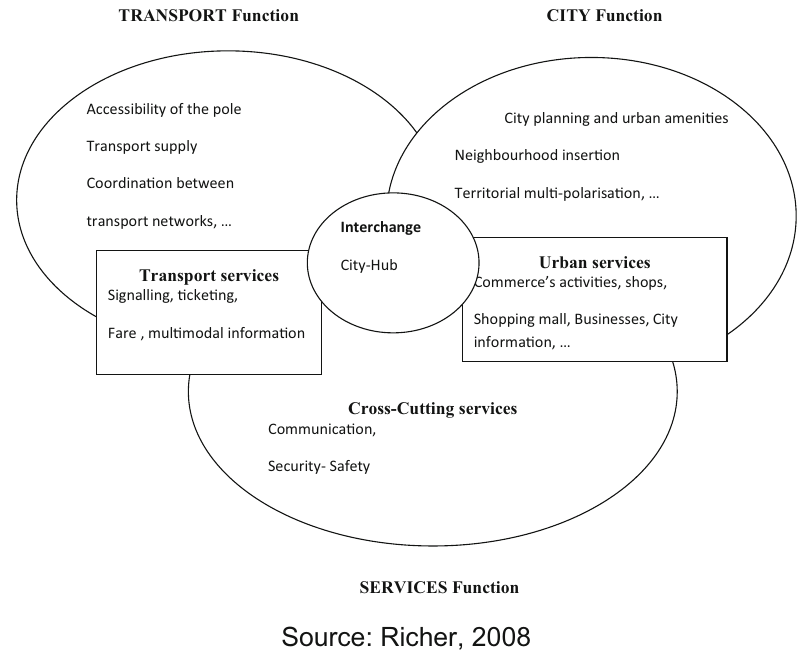
CITY Function TRANSPORT Function Fig. 1 The three functions of